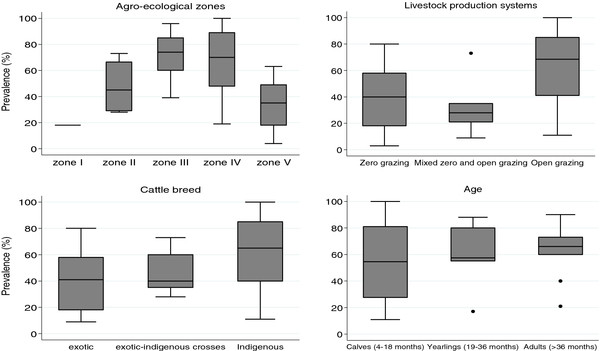
Box and whisker plots illustrating the distribution of prevalence (%) values by the identified factors obtained from the reviewed studies. The upper whisker represents the maximum value whereas the lower whisker represents the minimum value. The band at the middle of the box is the median value. The circles outside the whiskers are the ‘far out’ values. Prevalence median values progressively increase by AEZs up to zone IV then subside in zone V. Prevalence median values for open grazing system and for indigenous cattle are higher than for other production systems and cattle breeds respectively. Prevalence median values progressively increase with age.